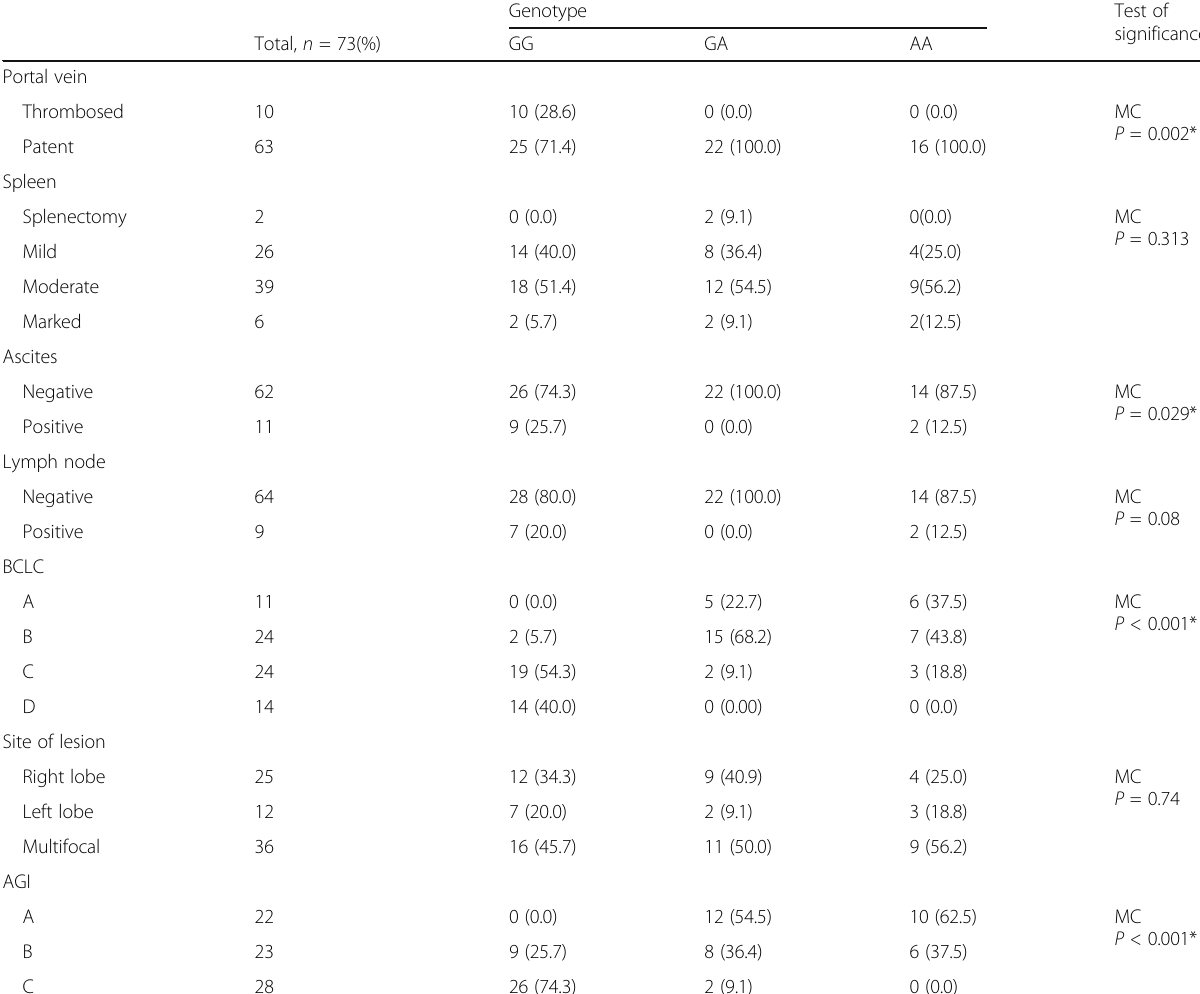
Table 5 Tumour characteristics of HCC cases according to TNF- ɑ polymorphism Genotype Test of